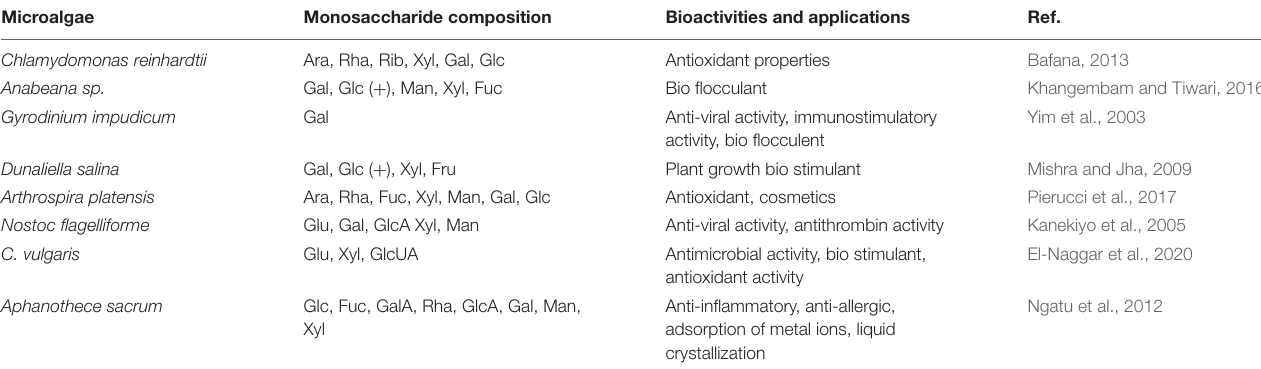
TABLE 6 | Composition of EPS of various microalgae with their bioactivities and